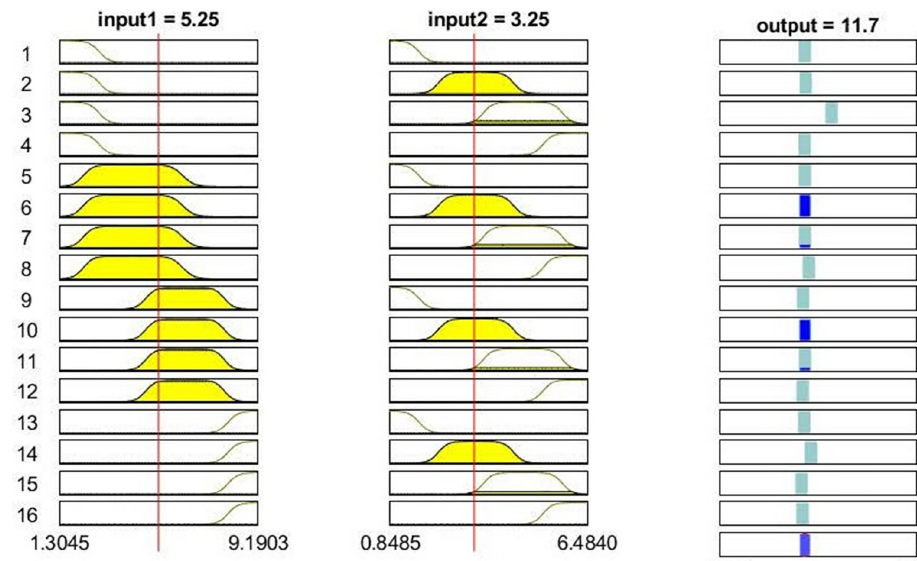
Fig 10. Fuzzy linguistic rules of optimized ANFIS model driven from 2019